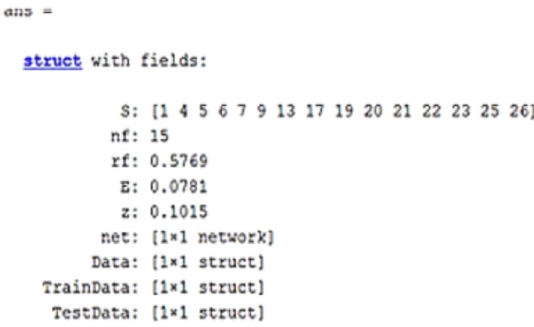
Figure 6. Result of implementing GA for selecting 15 effective factors in diet adherence.